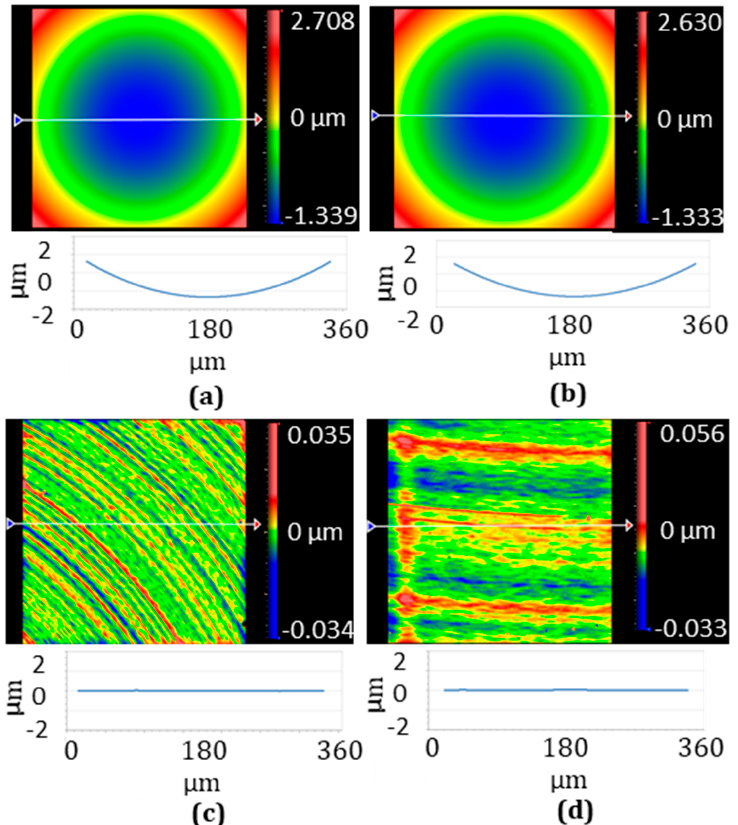
Figure 13. Measured surface of the concave lenslets fabricated with the tool path in Figure 12b. ( a , c ) Measured surface shapes of the concave lenslet in the center region before and after removing the designed spherical surface. ( b , d ) The results for the concave lenslet in the outer region.